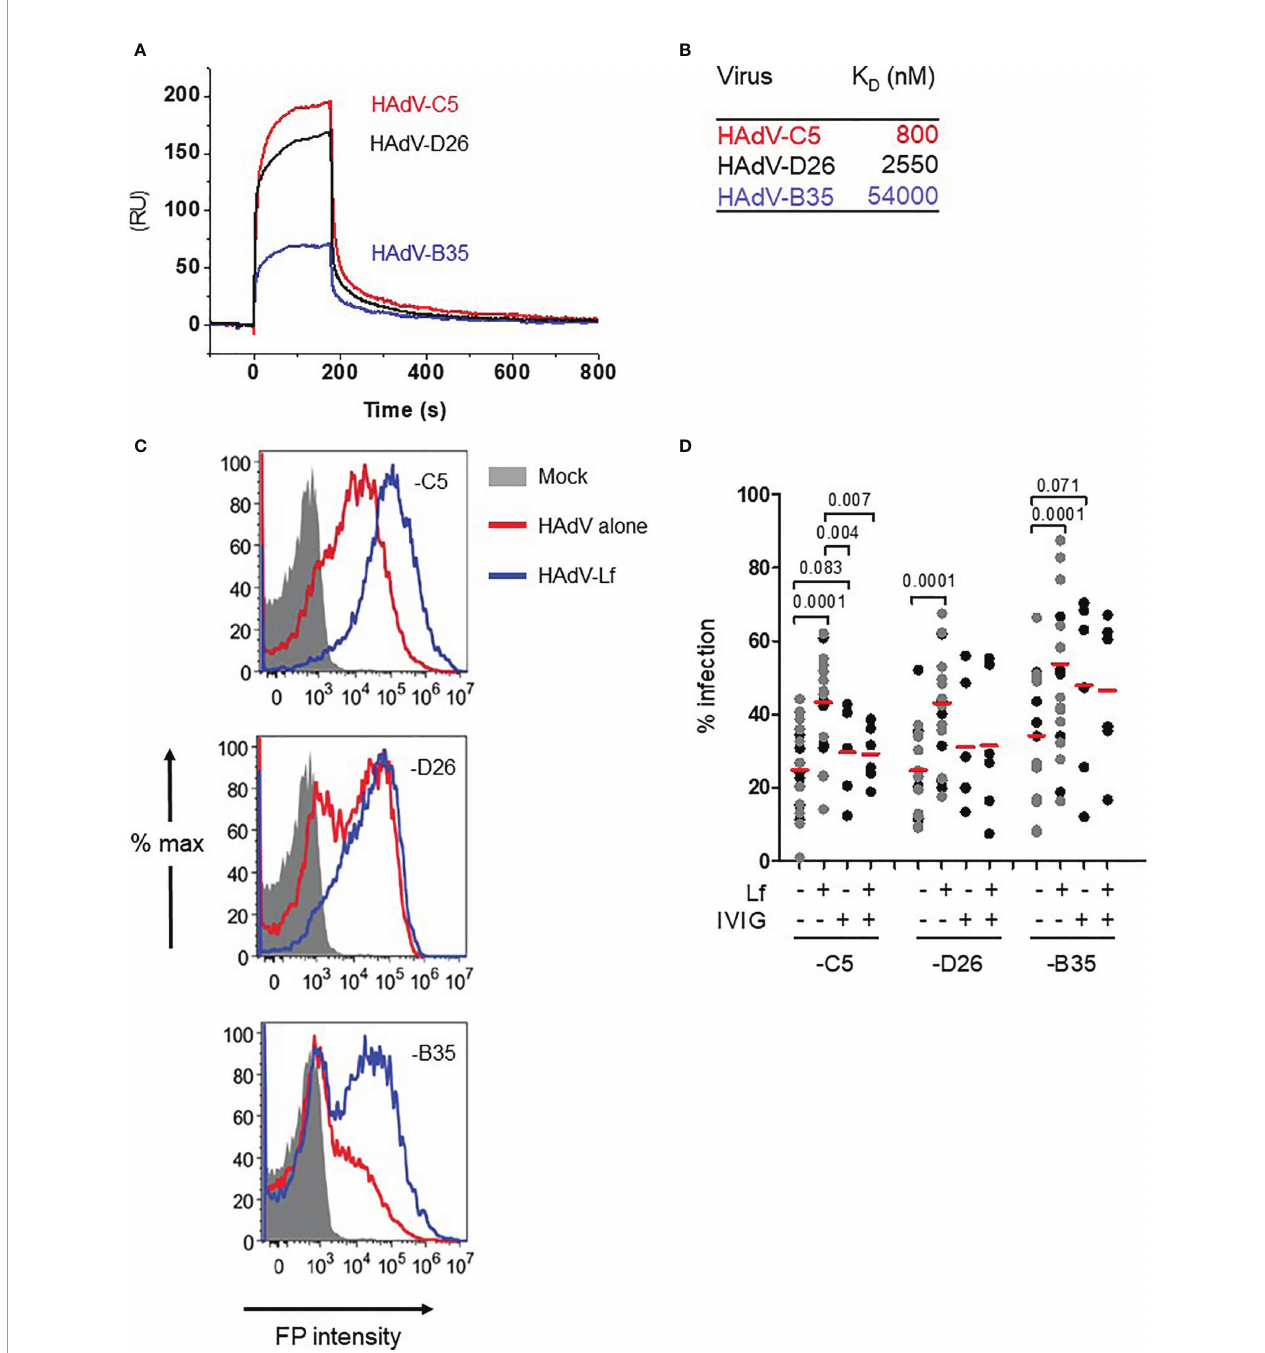
FIGURE 1 | Lactoferrin binds to HAdVs and enhances uptake by DCs. (A) Representative sensorgrams of lactoferrin binding to HAdV capsids as assessed by surface plasmon resonance: HAdV-C5 (red), HAdV-D26 (black), and HAdV-B35 (blue) were covalently coupled to the CM5 sensor chip and lactoferrin was injected for binding comparison. For KD determination a range of 6.25 - 200 nM of lactoferrin was injected and the KD was calculated using a bivalent fi tting model (RU = resonance units); (B) Relative af fi nity (KD) of lactoferrin for HAdV-C5, -D26 and -B35 capsids; (C) Representative fl ow cytometry pro fi les of DCs incubated with the HAdVs. DCs were mock-treated (grey) or incubated with HAdV-C5 (5,000 physical particles (pp)/cell), -D26 (20,000 pp/cell) or -B35 (1,000 pp/cell) (red) or with lactoferrin (blue). The samples were collected 24 h later, prepared for fl ow cytometry and 25,000 events were acquired/sample. FP = fl uorescent protein (GFP or YFP); (D) Cumulative data from DCs using HAdVs complexed with lactoferrin, IVIG or both. Statistical analyses by two-tailed paired t-test for comparison of HAdV vs. HAdV + lactoferrin (n = 21). A subset of these samples (n ≥ 5, in black) was used for analyses between HAdV + lactoferrin vs. HAdV+ lactoferrin